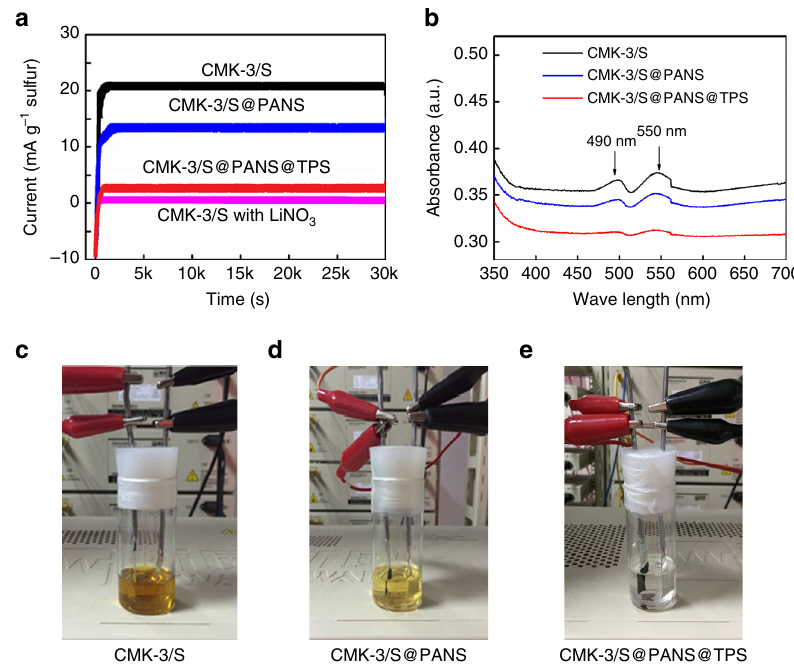
Fig. 5 Suppression of polysul fi de shuttling using in situ wrapping. a Shuttle current pro fi les of CMK-3/S, CMK-3/S@PANS, and CMK-3/S@PANS@TPS cathodes and a CMK-3/S cathode in an electrolyte with 1 wt% lithium nitrate (measured at a constant holding potential of 2.28 V). b UV – vis absorption spectra of the electrolytes after 20 cycles with various cathodes in glass cells at 0.1 C. c – e Photographs of CMK-3/S, CMK-3/S@PANS, and CMK-3/S@PANS@TPS cathodes after 20 cycles at 0.1 C in sealed glass